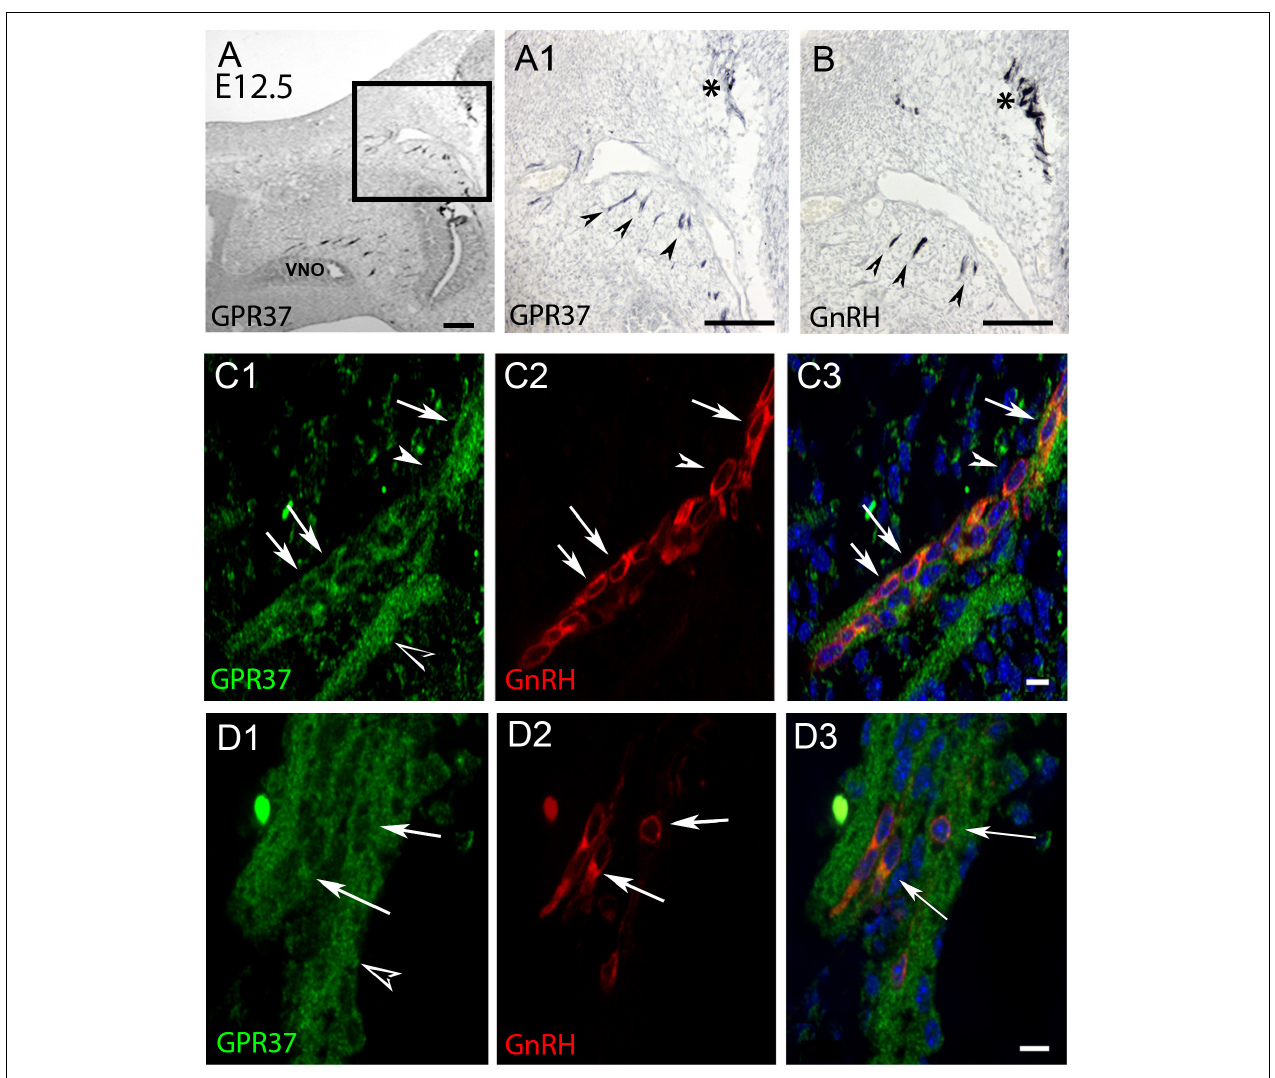
FIGURE 2 | GPR37 expression increases in nasal region at E12.5. and overlaps with GnRH cell expression pattern. Consecutive sections (A,B) show GPR37 expression ( A1 : higher magnification of boxed region in A ) in cells in tracts (arrowheads) that coincide with the tracts that GnRH cells ( B , arrowheads) use to migrate to the nasal forebrain junction ( A1,B , asterisk). Double label immunofluorescence confirms that GPR37 (green) is expressed in GnRH cells (red) in the migratory tracks (C) and nasal forebrain junction (D) . White arrows indicate double-labeled cells ( C,D , merged image is shown in C3,D3 ). However, some GnRH positive cells are GPR37 negative ( C , arrowhead) and GPR37 staining appears in elements surrounding the GnRH cells ( D1 , black arrowhead). Scale bar: (A) = 40 µ m, (A1,B) = 100 µ m, (C,D) = 10 µ m.